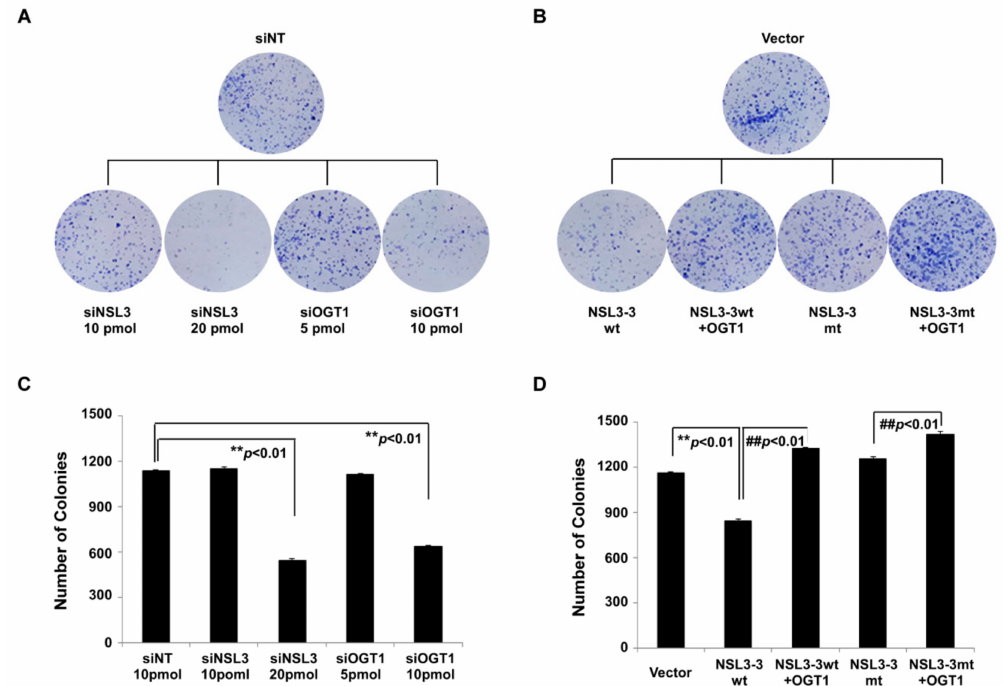
Figure 7. The OGT1 / O -GlcNAcylation-mediated NSL3 stability impacted the proliferation of A549 cells. ( A , B ) Colony formation assay ( n = 3): A549 cells were treated with indicated siRNA ( A ) or transfected with plasmids ( B ) as indicated design. Forty-eight hours later, cells were collected and split into a new 6-well plate with 2400 cells / well. Two weeks later, formed colonies were stained with Giemsa. ( C , D ) Number of colonies: images of stained colonies containing > 20 cells were scored as positive. The number of foci > 100 µ m was counted. Counted numbers of colonies are shown as a bar graph; ** p < 0.01 ( t -test), compared with siNT or vector group; ## p < 0.01 ( t -test), compared with NSL3-3wt or NSL3-3mt only